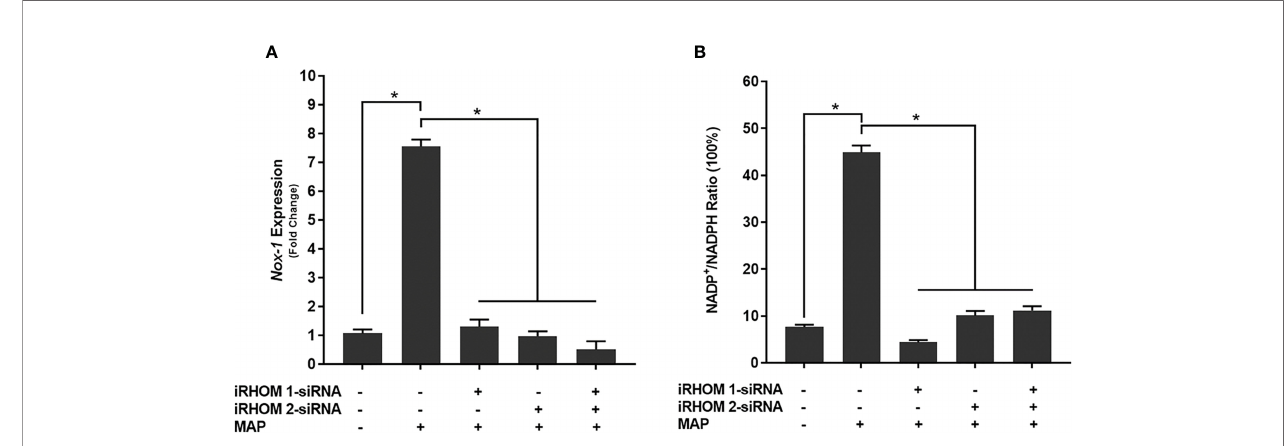
FIGURE 8 | How regressing TACE traf fi cking affects (A) the expression of NADPH oxidase-1 ( NOX-1 ) and (B) the resulting ratio of NADP + /NADPH in co-cultured Caco-2 monolayers. The Kolmogorov – Smirnov normality test was used to test the normal distribution for all values and a two-way analysis of variance (ANOVA) was used to assess signi fi cance among experiments, which was followed by a Bonferroni correction test. All experiments were performed in triplicates. *Indicates P-value of less than 0.05.